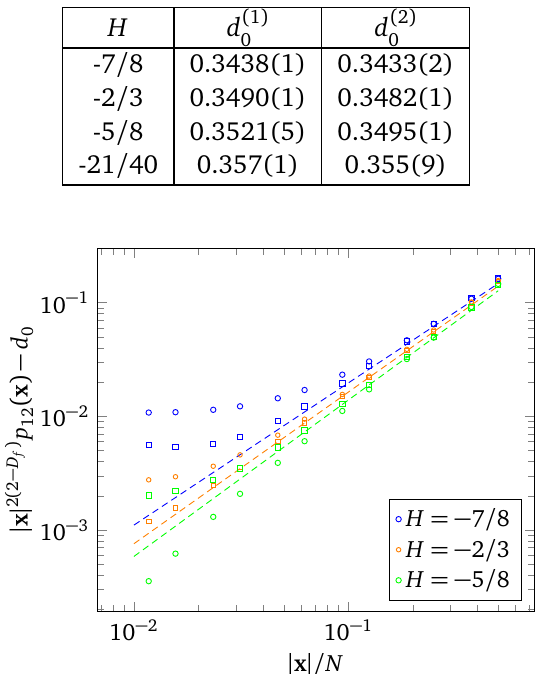
Table 1: Non universal constant d ated (1) with kernel (46) and (2) with kernel (50).